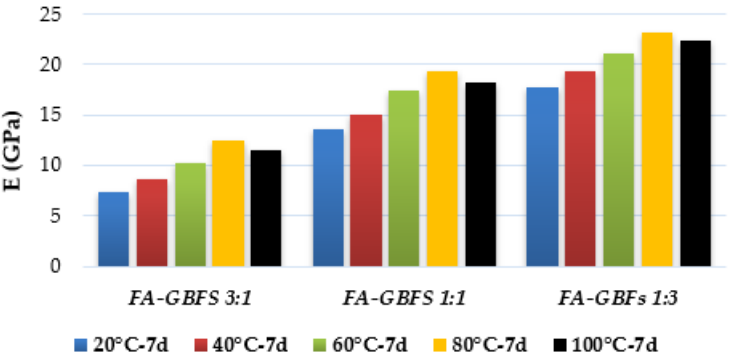
Figure 13. Effect of curing temperature and FA-GBFS ratio on 7-days elastic modulus (adapted from [59]).